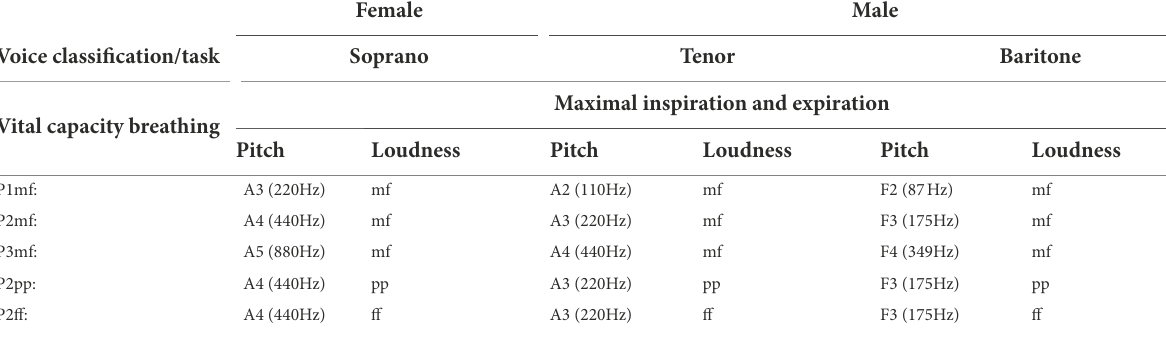
TABLE 2 List of the tasks performed by the subjects according to different voice classifications including pitch and